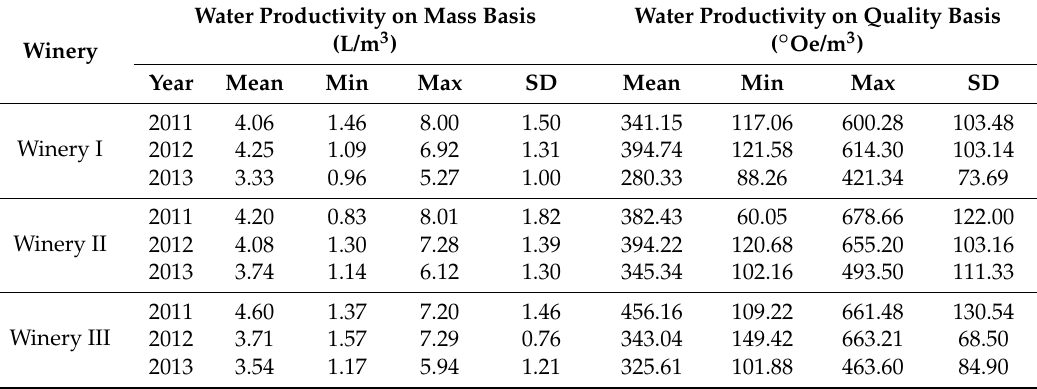
Water productivity on a mass basis (L/m 3 ) and on a quality basis ( ◦ Oe/m 3 ) (SD = standard